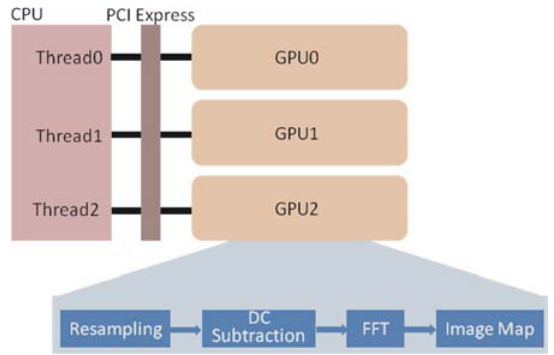
Fig. 1. Flowchart of multi-GPU signal